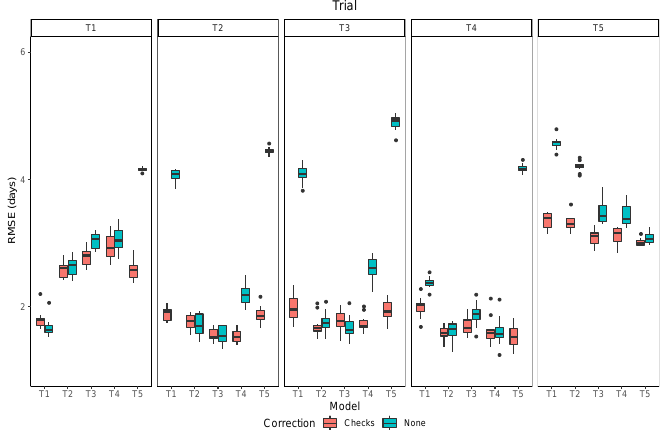
Figure 8. Prediction performance measured by the root mean squared error (RMSE) for the raw model outputs and after the correction using the check